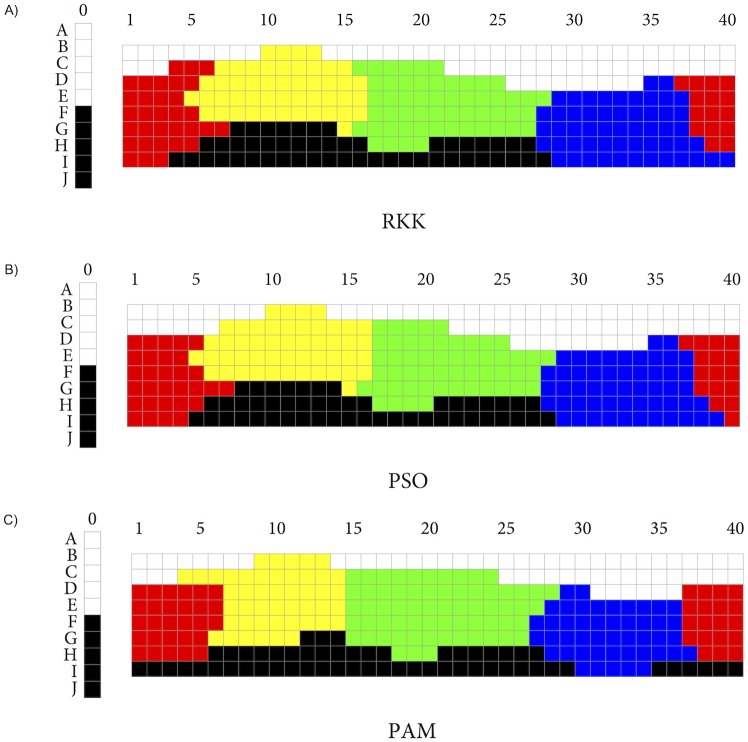
Solutions for n = 6.